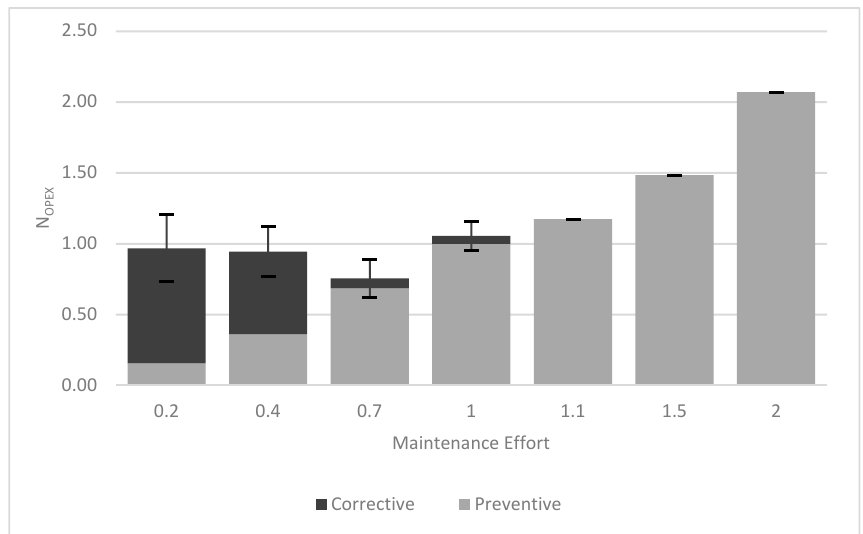
Figure 12. Normalised OPEX (N OPEX ) for different Maintenance Efforts (M e ) calculated by the DTOcean O&M Module case study. Error bars shows the uncertainty range between results with a probability of 68% of the results.